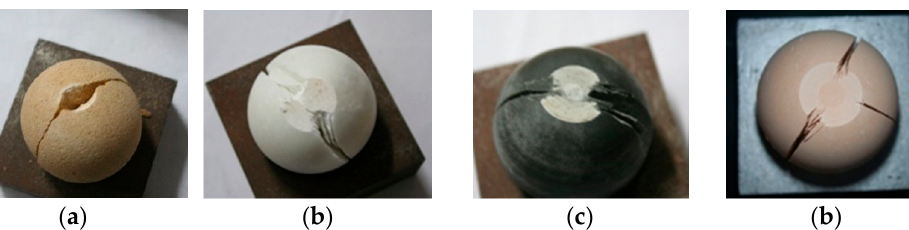
Figure 1. Comparison of breakage modes between natural and gypsum particles: ( a ) sandstone; ( b ) limestone; ( c ) slate; ( d ) gypsum.